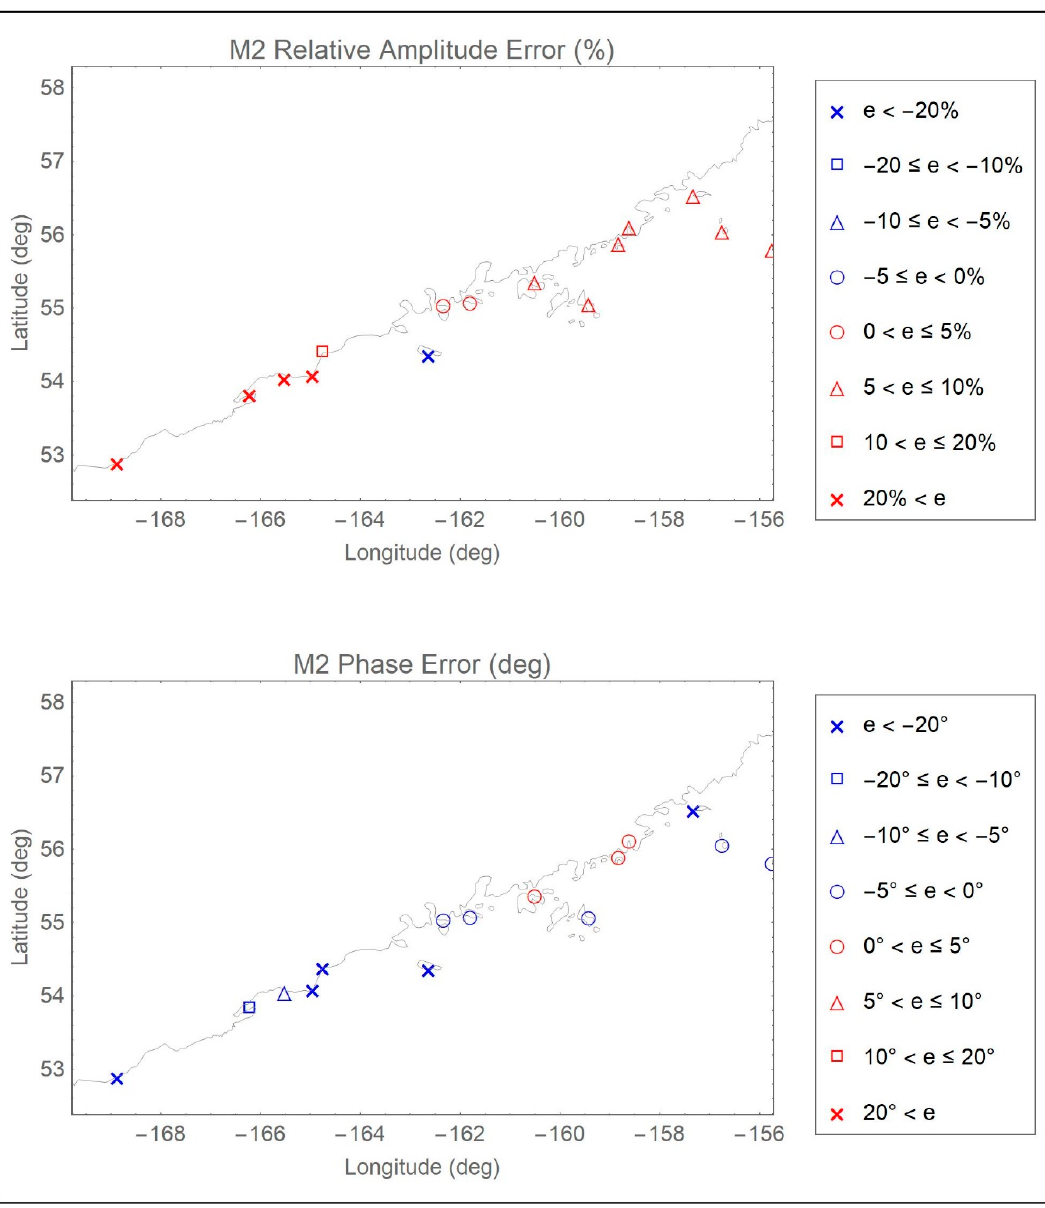
Figure A25. Distribution of ENPAC15 relative amplitude (%) and absolute phase (deg) errors for the M 2 constituent: Southern Alaska coast view two.